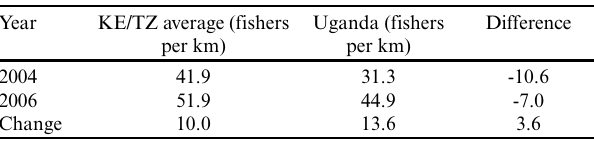
Table 1 . Difference-in-difference changes in fishers per km of shoreline in Kenya/Tanzania and Uganda, 2004 to 2006.